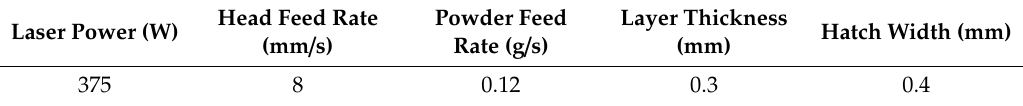
Table 2. Parameters for the additive manufacturing by LENS method of a sample made of SS316L. Laser Power